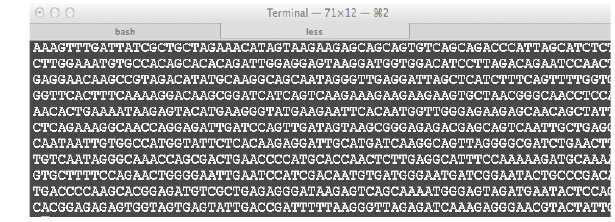
Figure 1. CS1: Random Text Generation Figure 2. H1N1 DNA Sequence Samples